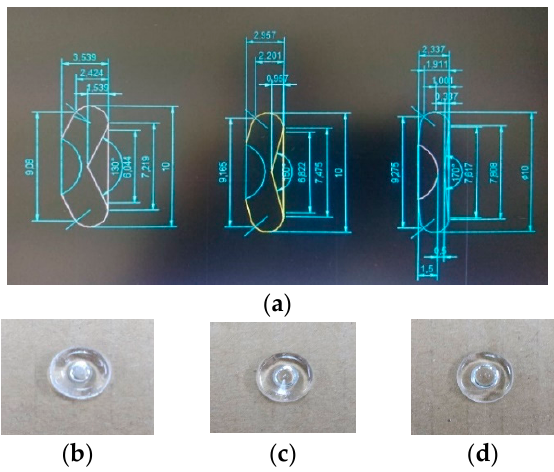
Figure 5. ( a ) SFL mechanical drawing; ( b ) 130° SFL prototype; ( c ) 150° SFL prototype; ( d ) 170° SFL prototype.